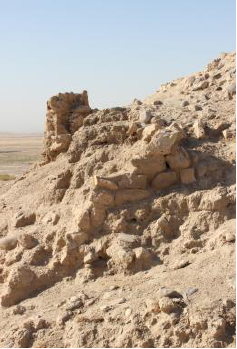
Figure 9 – View on a ruined structure in the southern front of